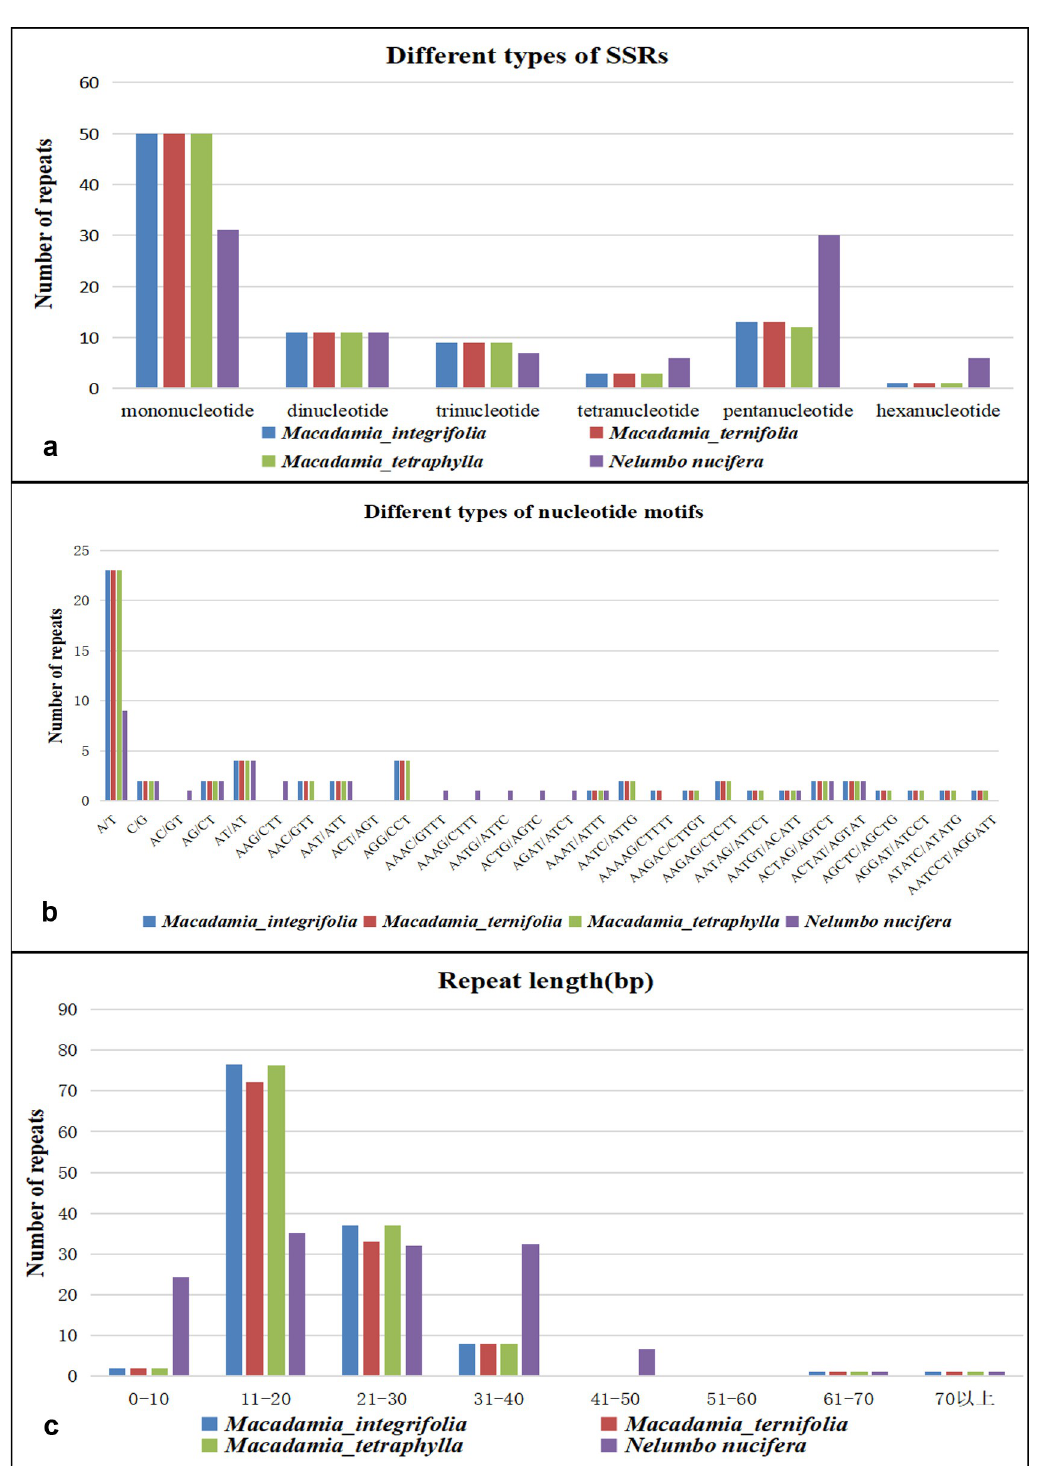
Fig 3. The comparison of microsatellites and oligonucleotide repeats in three Macadamia species and N . nucifera mitochondrial genomes.